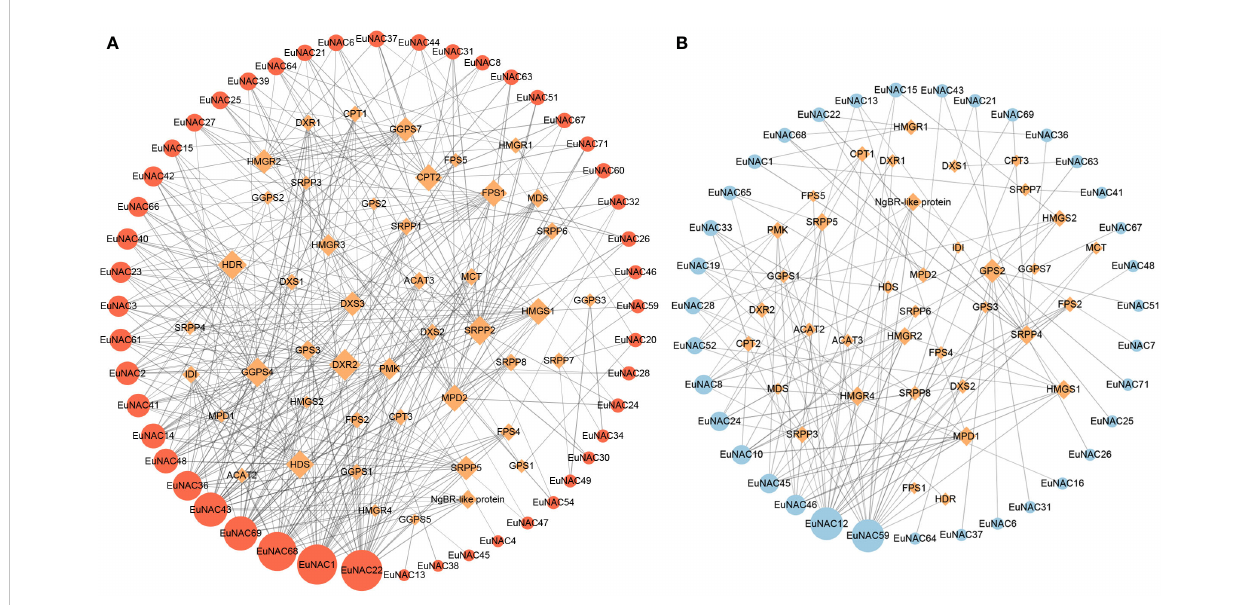
FIGURE 9 Co-expression networks between EuNAC genes and Eu-rubber biosynthesis genes. (A) Positive regulatory co-expression network between EuNAC genes and Eu-rubber biosynthesis genes. (B) Negative regulatory co-expression network between EuNAC genes and Eu-rubber biosynthesis genes. Orange diamond nodes represent Eu-rubber biosynthetic structural genes. Red circular nodes represent positively regulated EuNAC genes, and blue circular nodes represent negatively regulated EuNAC genes. The node size is positively correlated with the degree of the connectivity of the genes. The width of the connecting line is positively related to the correlation between